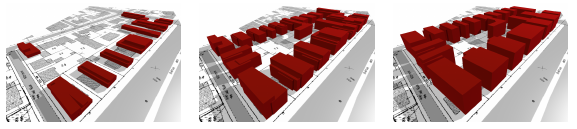
Figure 5. Different simulation results by adjusting some regula- tion